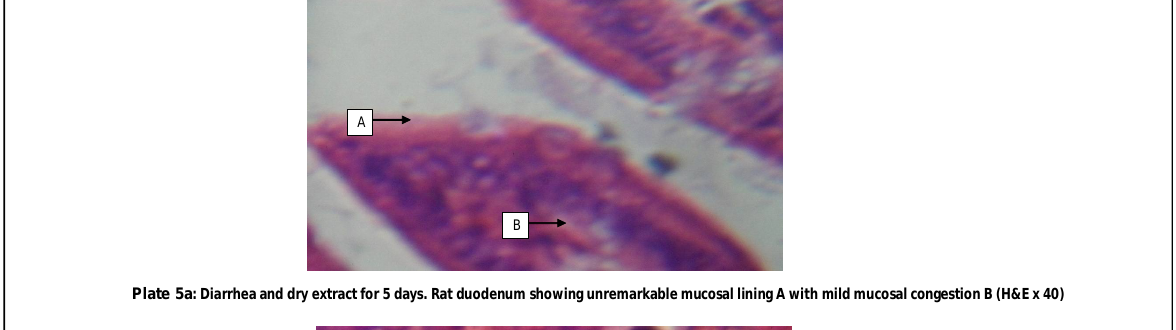
Plate 5a :Diarrheaand dryextractfor5days.Ratduodenum showingunremarkablemucosalliningAwith mildmucosalcongestionB(H&Ex 40)